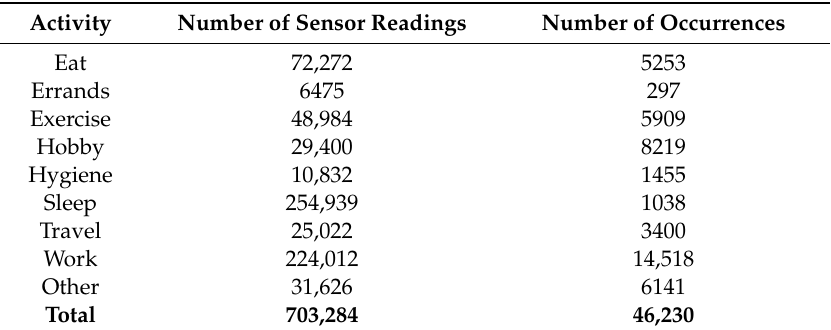
Table 3. Data sample size for each activity category.